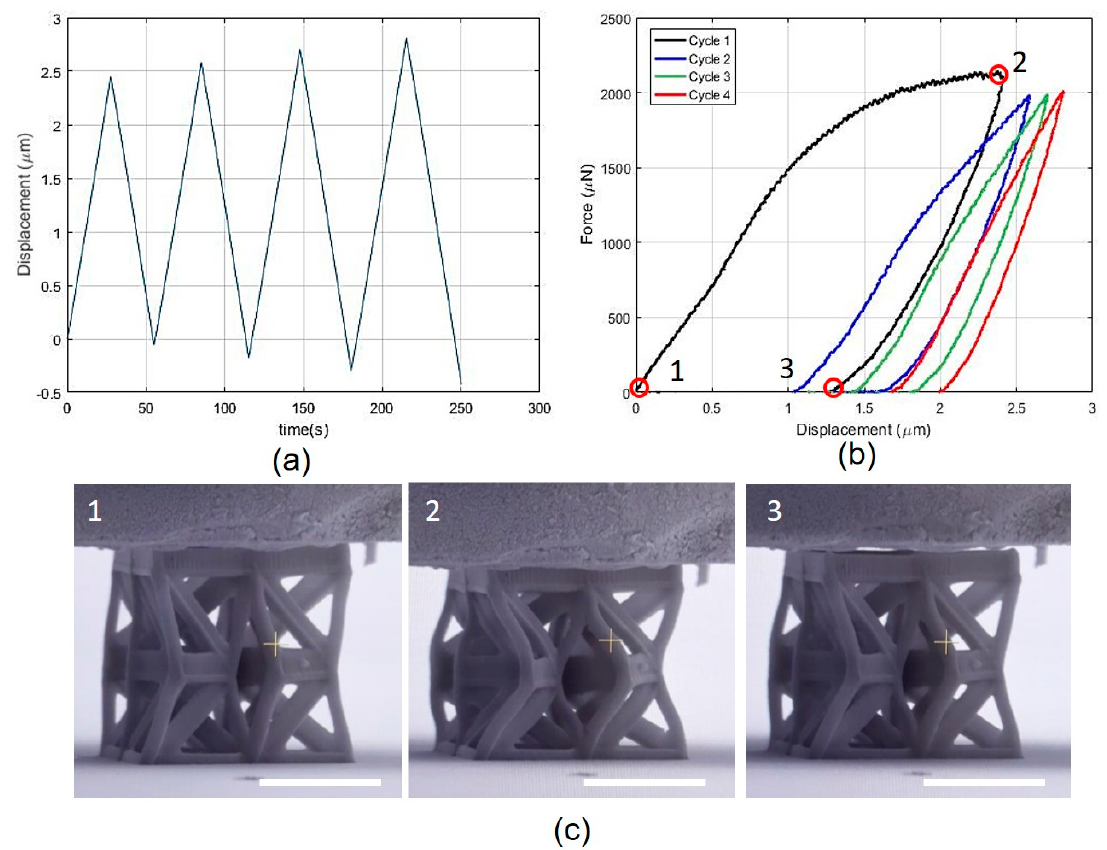
Figure 7. Mechanical testing on a three-unit array. ( a ) Imposed displacement vs. time and ( b ) force vs. displacement plots. ( c ) Snapshots of the sample during testing (cf. Video S3: Three-unit array). The white scale bar for each SEM figure is 8 μ m.